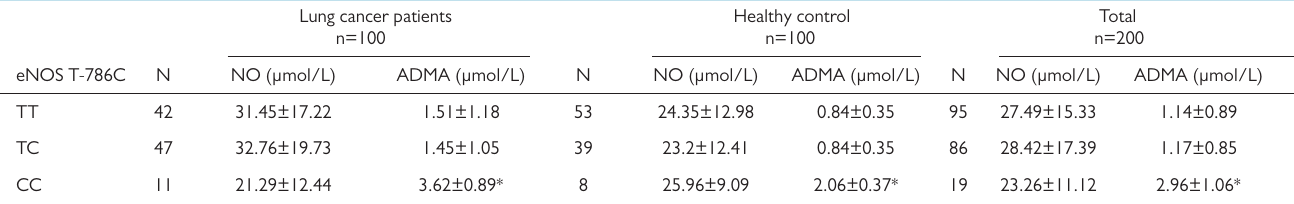
Table 4. ADMA and NO levels in groups according to eNOS T-786C polymorphisms